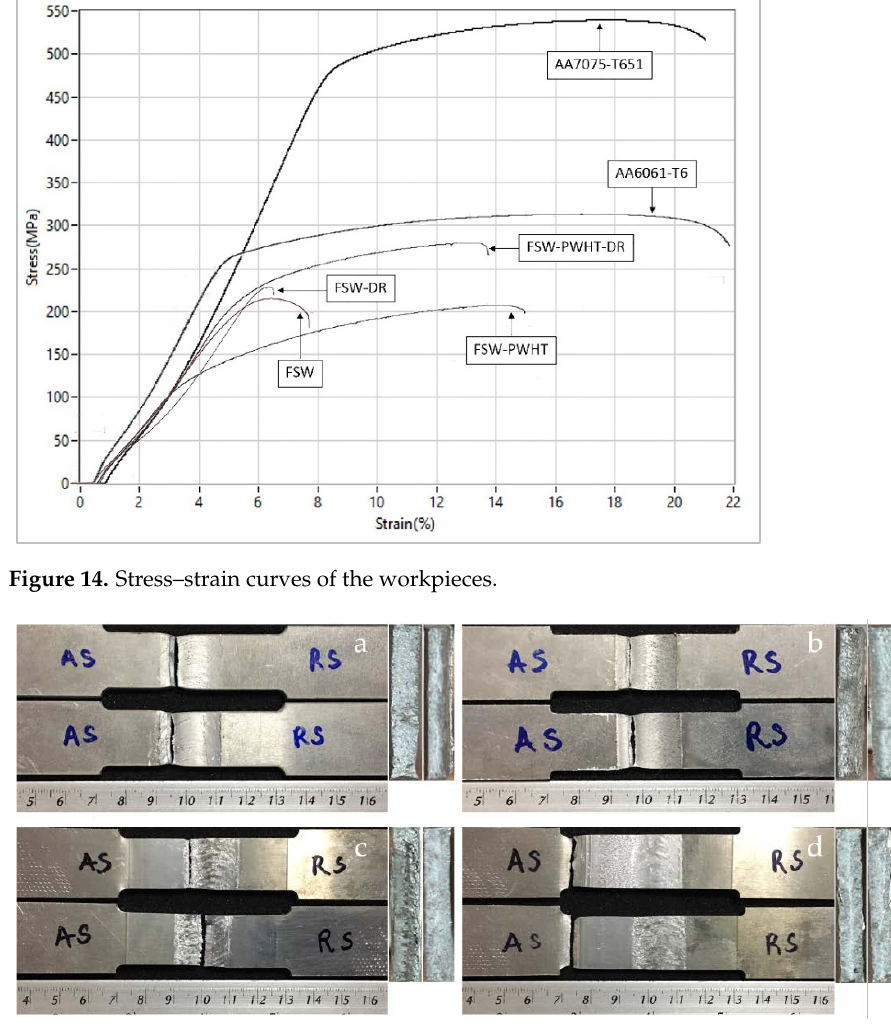
Figure 15. Photographs of the broken workpieces from tensile testing: ( a ) FSW; ( b ) FSW-PWHT; ( c ) FSW-DR; ( d ) FSW-PWHT-DR.